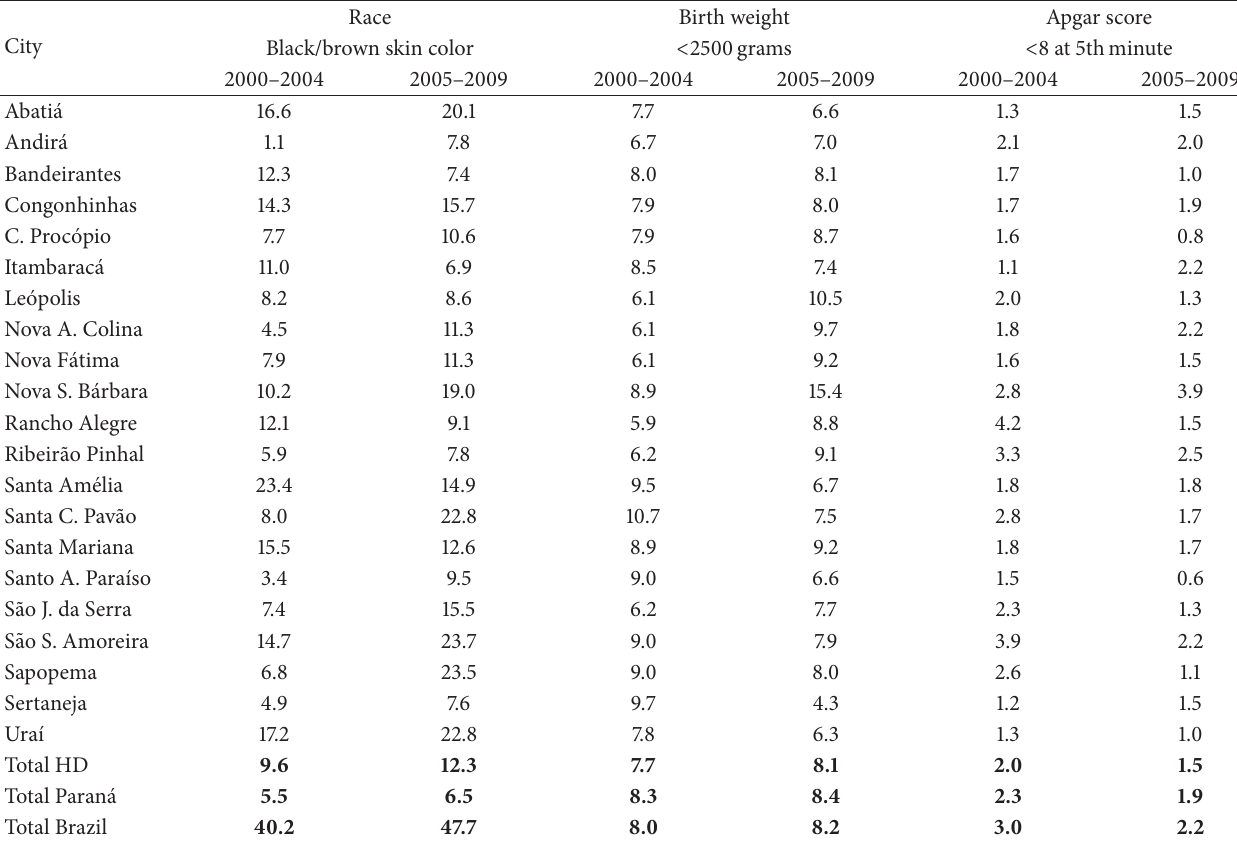
Table 4: Distribution of percentage means according to neonatal variables, 18th HD, Paran´a, from 2000 to 2004 and from 2005 to 2009. Race Birth weight Apgar score City Black/brown skin color < 2500 grams < 8 at